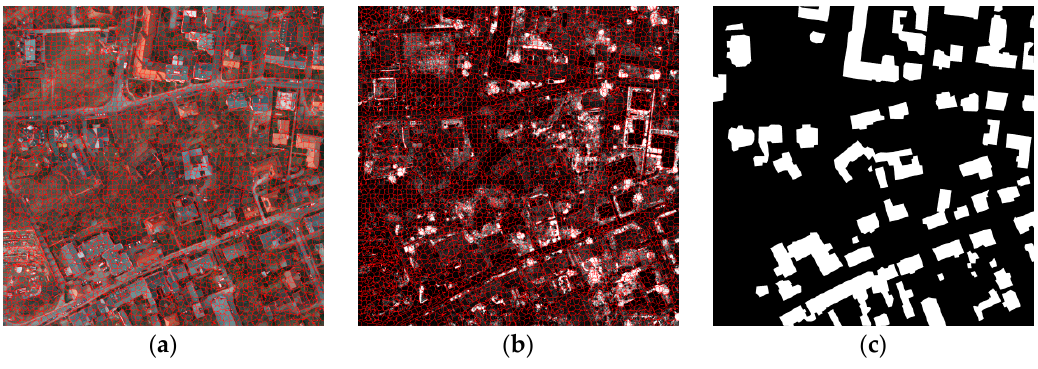
Figure 15. Results of 6D-SLIC, vegetation removal, and superpixel merging in two UAV datasets. Red lines in ( a ) and ( b ) show the boundaries of superpixels obtained from the 6D-SLIC algorithm. White regions in ( c ) and ( d ) are the vegetation obtained from the proposed GGLI algorithm. Green, red, and blue in ( e ) and ( f ) denote the vegetation, building, and non-building regions, respectively. ( g ) and ( h ) are the buildings extracted by using the proposed framework, and white color denotes the building areas.